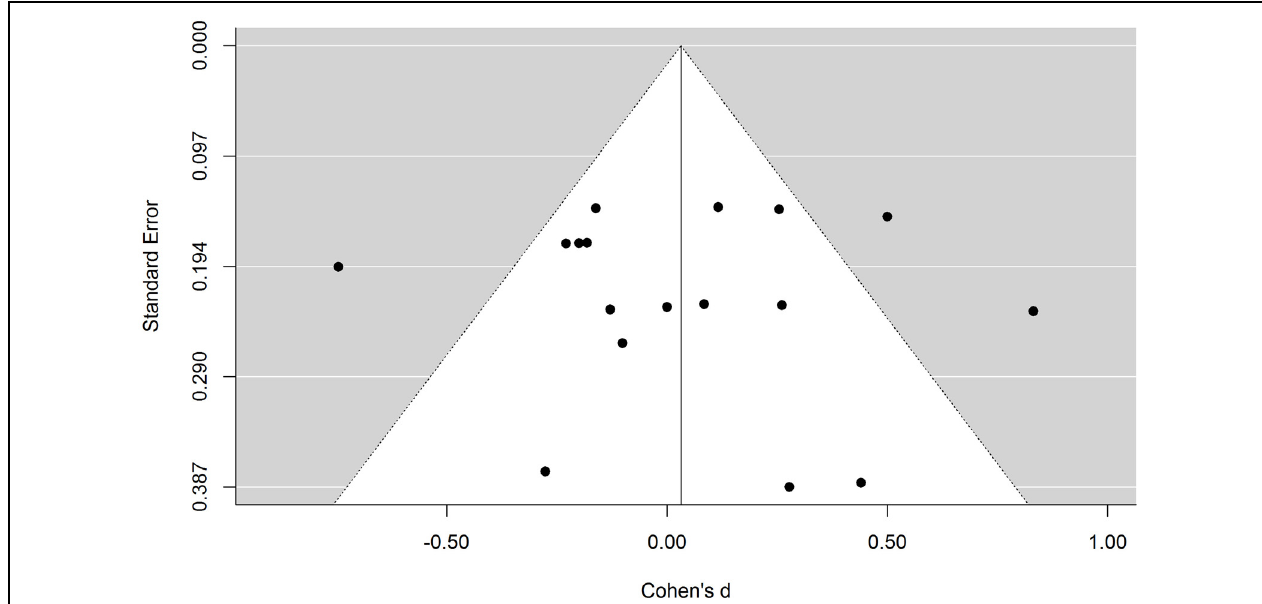
FIGURE 2 | Funnel plot of the first-meta-analysis. Each data point represents the effect size and the standard error of one experimental condition. The white area represents a pseudo confidence-interval region around the effect-size estimate with bounds equal to ± 1.96 standard error.